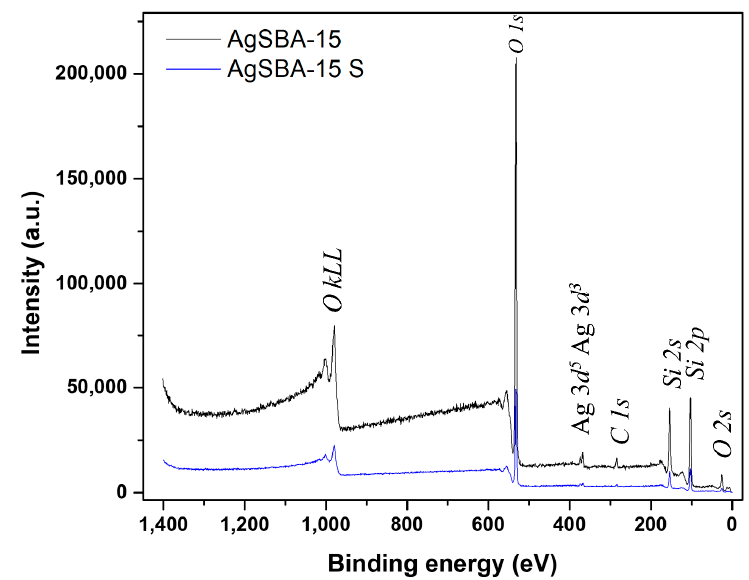
Figure 5. X-ray photoelectron spectroscopy (XPS) spectra for 2AgSBA-15 and 2AgSBA-15 S. Catalysts 2020 , 10 , x FOR PEER REVIEW